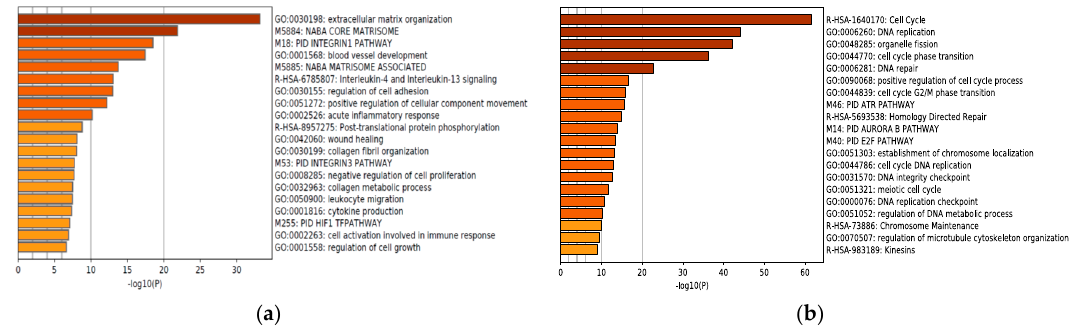
Figure 1. The workflow of RNA-seq and data analysis used in this study. Next Generation Sequencing reads sequenced with the Illumina Hiseq 2500 were aligned to the hg19 genome + transcriptome assembly (UCSC hg19) using TopHat v2.1.1 with the default parameters. Read counts of each gene were obtained using HTSeq and differential expression was analyzed using DESeq. Gene Ontology (GO) analysis and Gene Set Enrichment Analysis (GSEA) were performed to interpret the results.